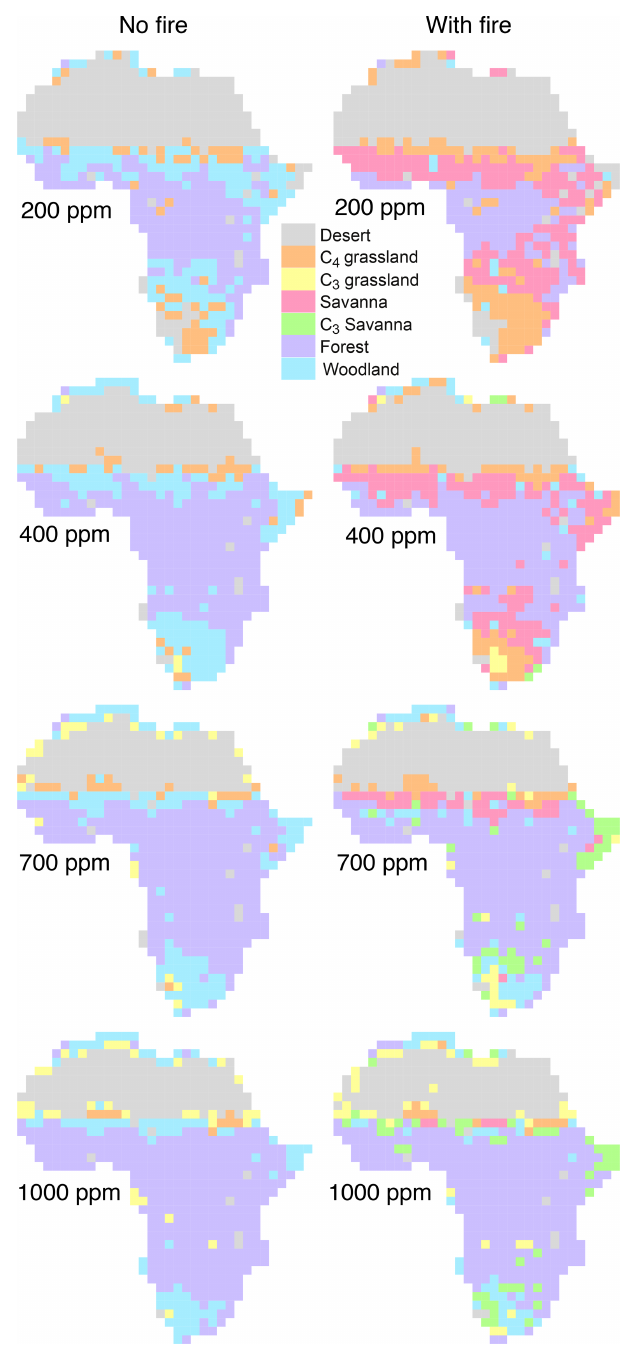
Figure 2. Biome distribution at different CO 2 mixing ratios and in the presence or absence of fire. Simulations were conducted until vegetation reached an equilibrium state under a constant CO 2 mix- ing